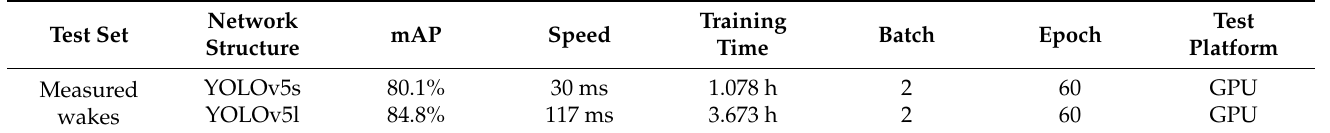
Table 5. Detection results of wake in the measured SAR images.